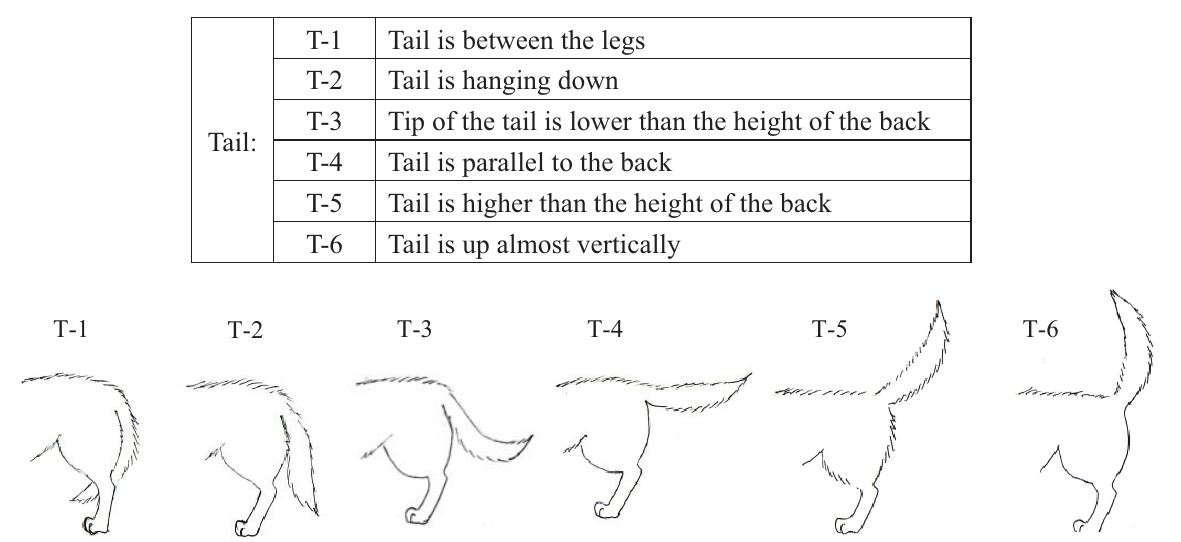
Figure 4. Categories of tail (T) body language in dogs during their training.